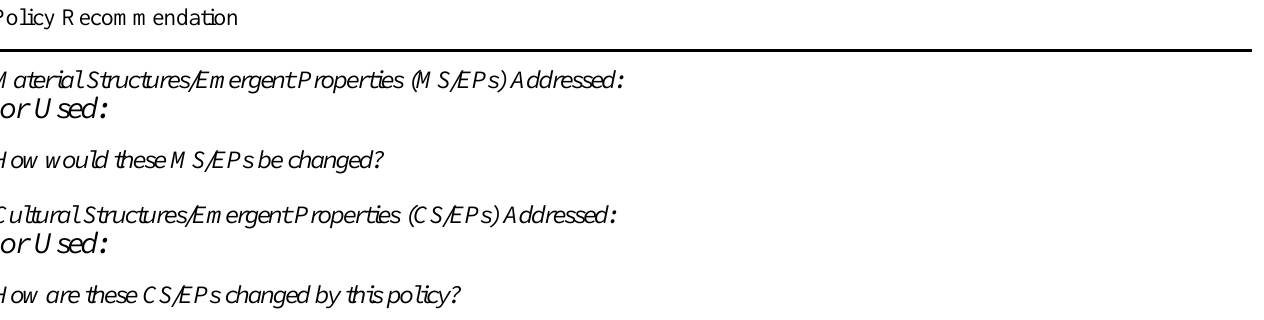
Table 2. Template for policy analysis Policy